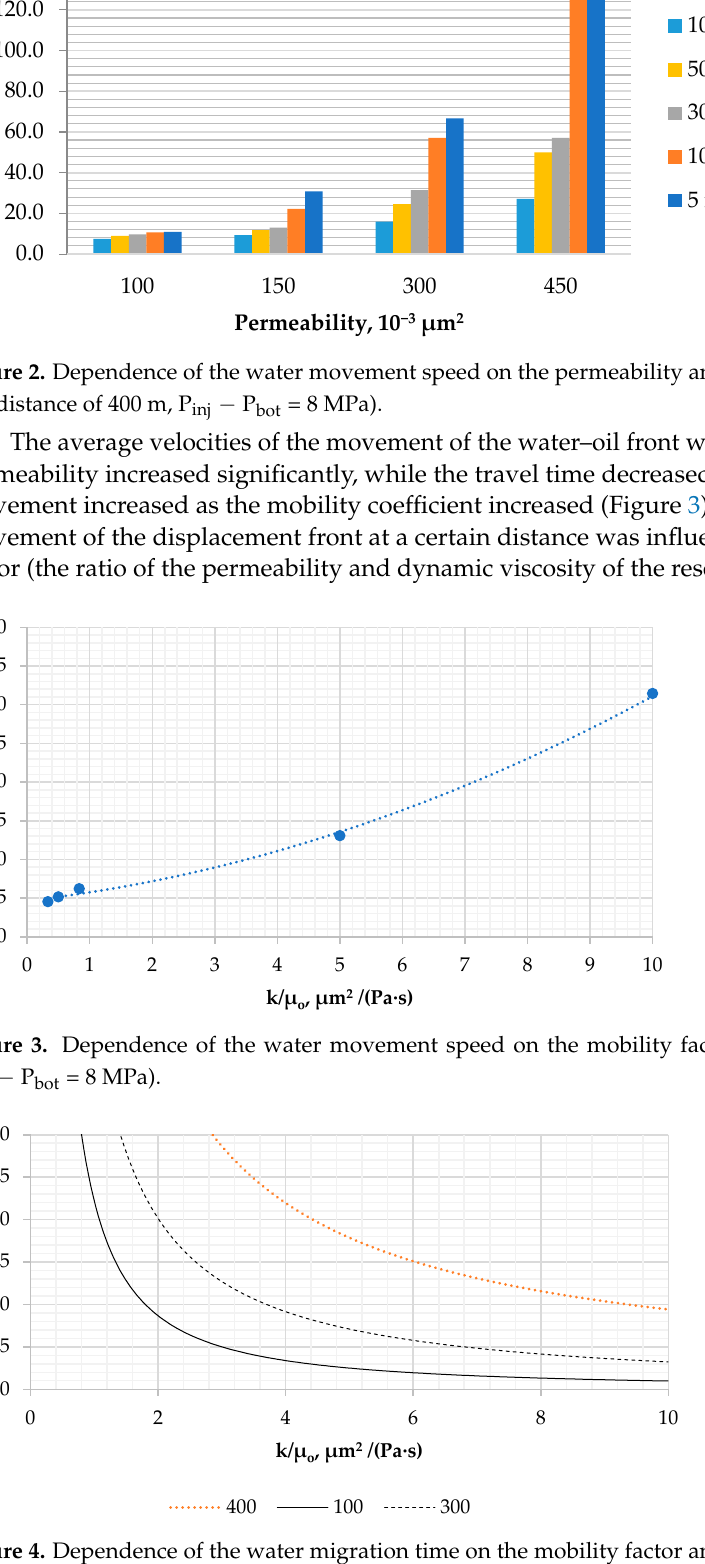
Figure 4. Dependence of the water migration time on the mobility factor and distances of 100, 300, and 400 m from the production well (P inj − P bot = 8 MPa).